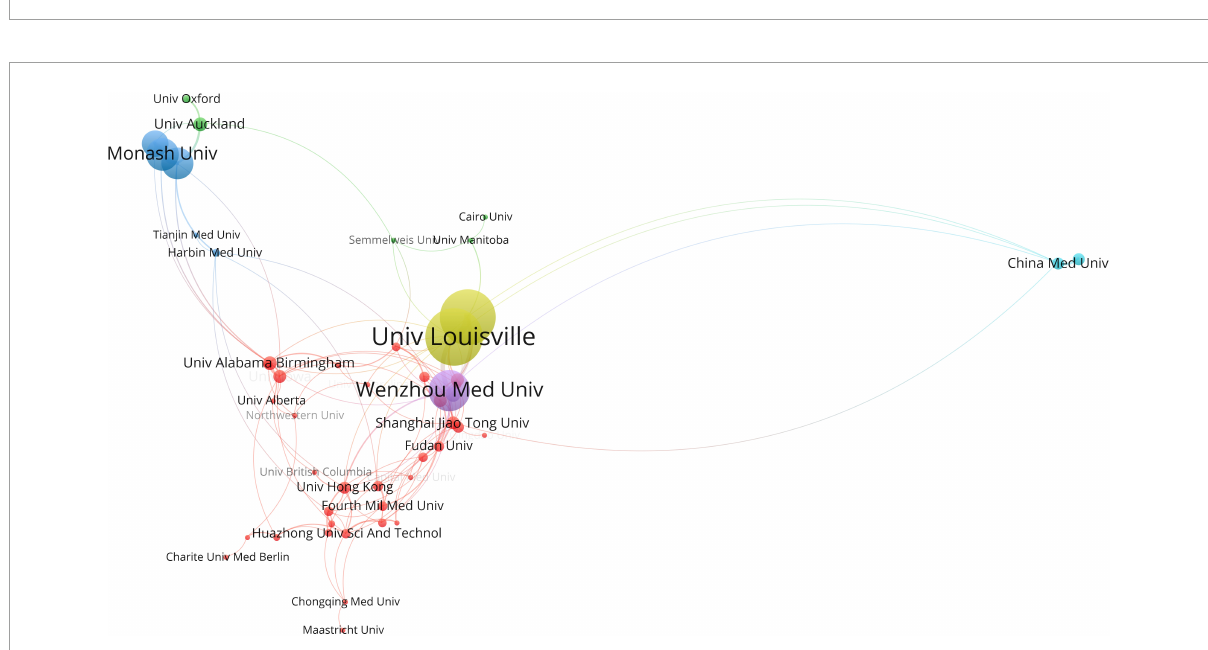
FIGURE3 Top 50 Countries’ collaboration network map in the field of DCM ranked by PageRank.